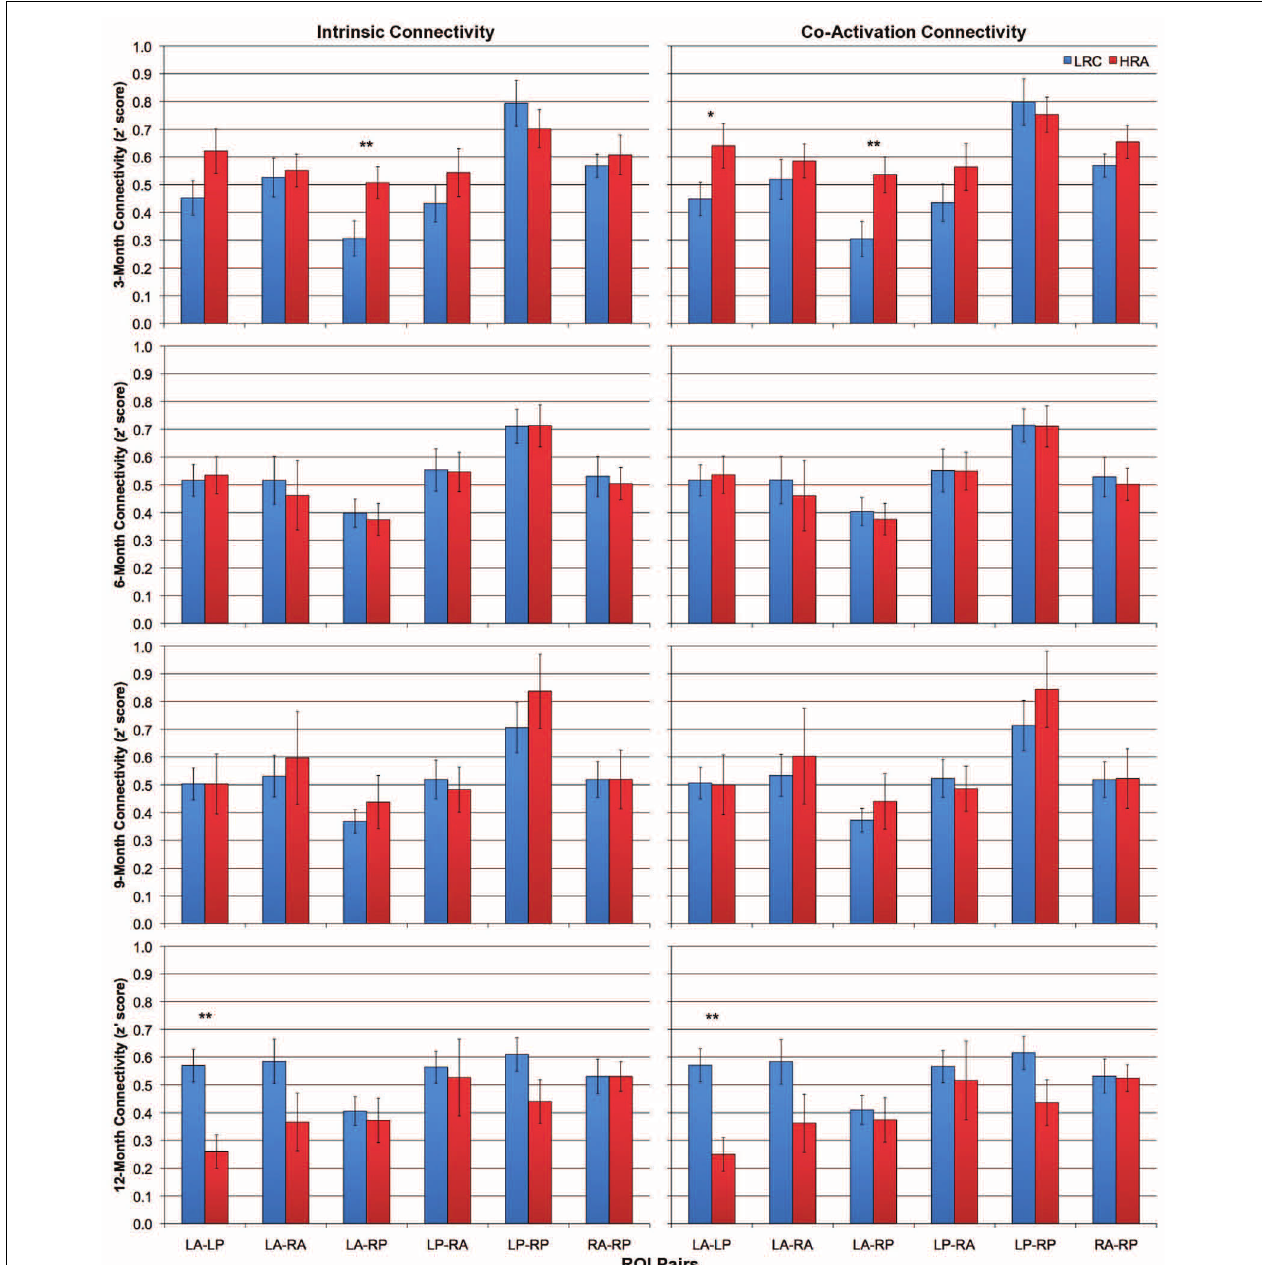
FIGURE 3 | Intrinsic (left column) and co-activation (right column) connectivity for HRA and LRC groups at 3-, 6-, 9-, and 12-months for all six ROI pairs. Error bars represent one standard error of the mean. ∗ p < 0 . 1, ∗∗ p < 0 . 05.